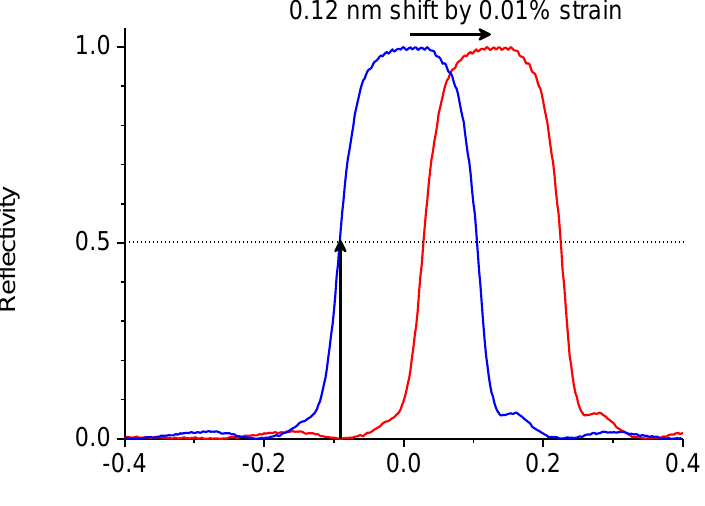
Figure 1. A typical reflection spectrum of a 10-mm-long fiber Bragg